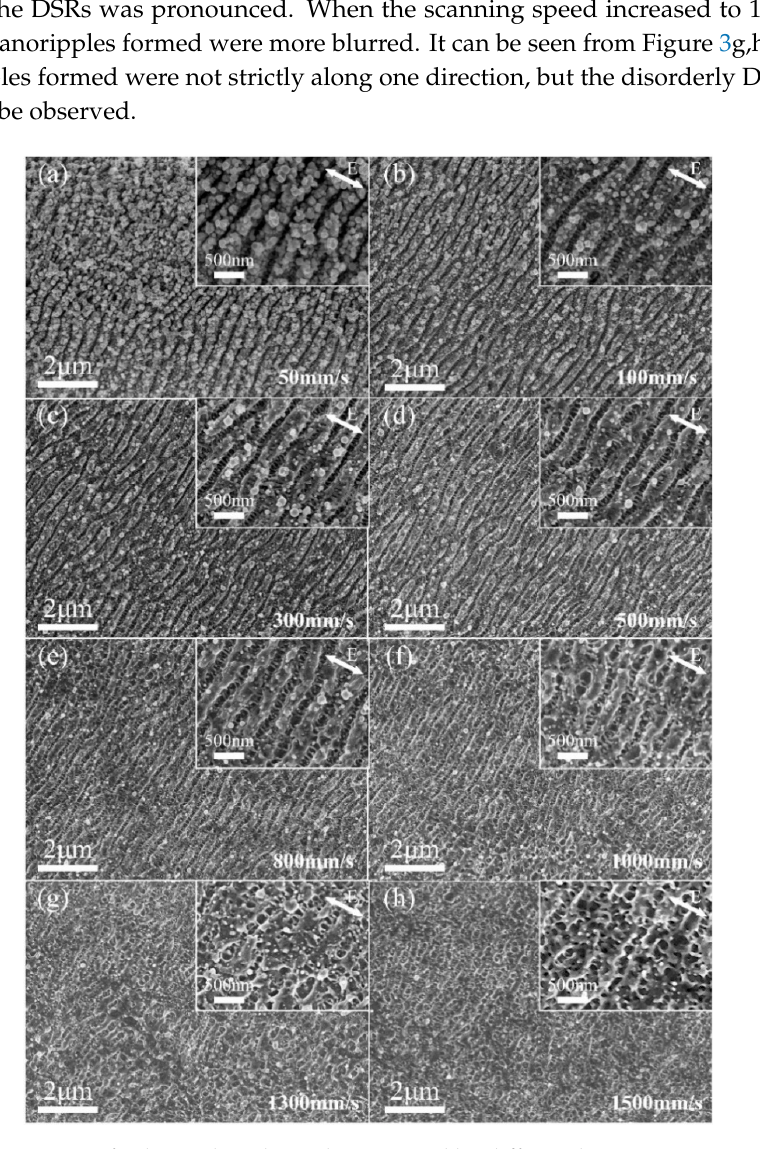
Figure 3. SEM images of subwavelength ripples prepared by different laser scanning speed and the fixed line spacing of 10 μ m. The laser scanning speed of ( a – h ) is set to 50, 100, 300, 500, 800, 1000, 1300, and 1500 mm/s, respectively. The insets are zoomed views of the selected areas. The polarization of incident laser is indicated by the white double-headed arrow.